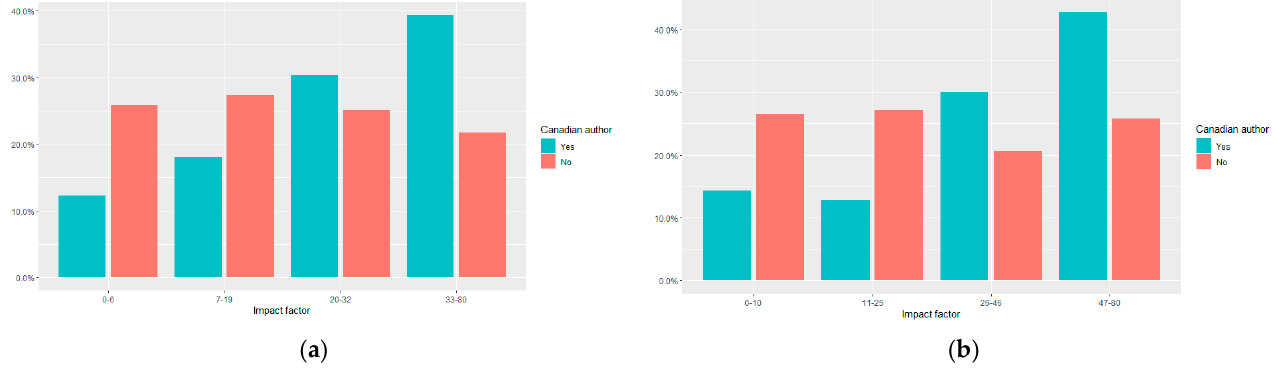
Figure 2. Journal impact factor of all oncology randomized controlled trials (RCTs) led by high ‐ income countries published globally 2014–2017. RCTs are stratified by involvement of Canadian authors. Histogram bars reflect quartiles of all impact factors: ( a ) impact factor of all HIC RCTs for which an impact factor was available ( n = 630); ( b ) impact factor for all positive superiority RCTs ( n = 225).